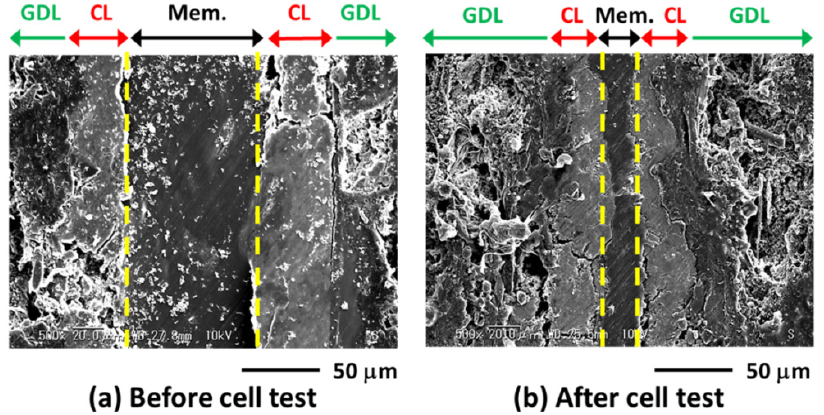
Figure 8. Cross-sectional SEM images of the MEAs using EMPyr(FH) 1.7 F/PVdF-HFP (7:3) composite membrane ( a ) before and ( b ) after cell test at 25  120  C. (GDL = gas diffusion layer, CL = catalyst layer, Mem. =